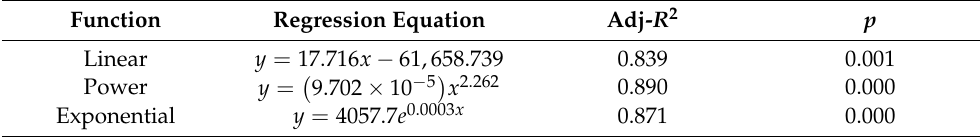
Table 7. Modelling results for annual night-light data obtained by the month-specific substitution method. Function Regression Equation Adj- R 2 p Linear y = 8.802 x − 26,956.863